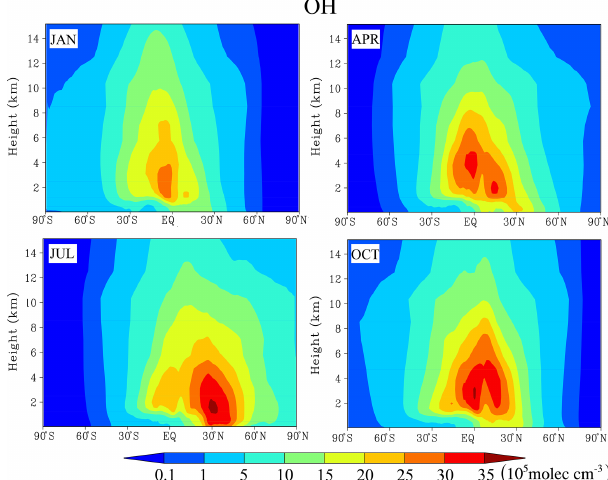
Figure 3. Zonal monthly mean concentration of OH in the tropo- sphere for January, April, July, and October from the IAP-AACM (in 10 5 moleccm − 3